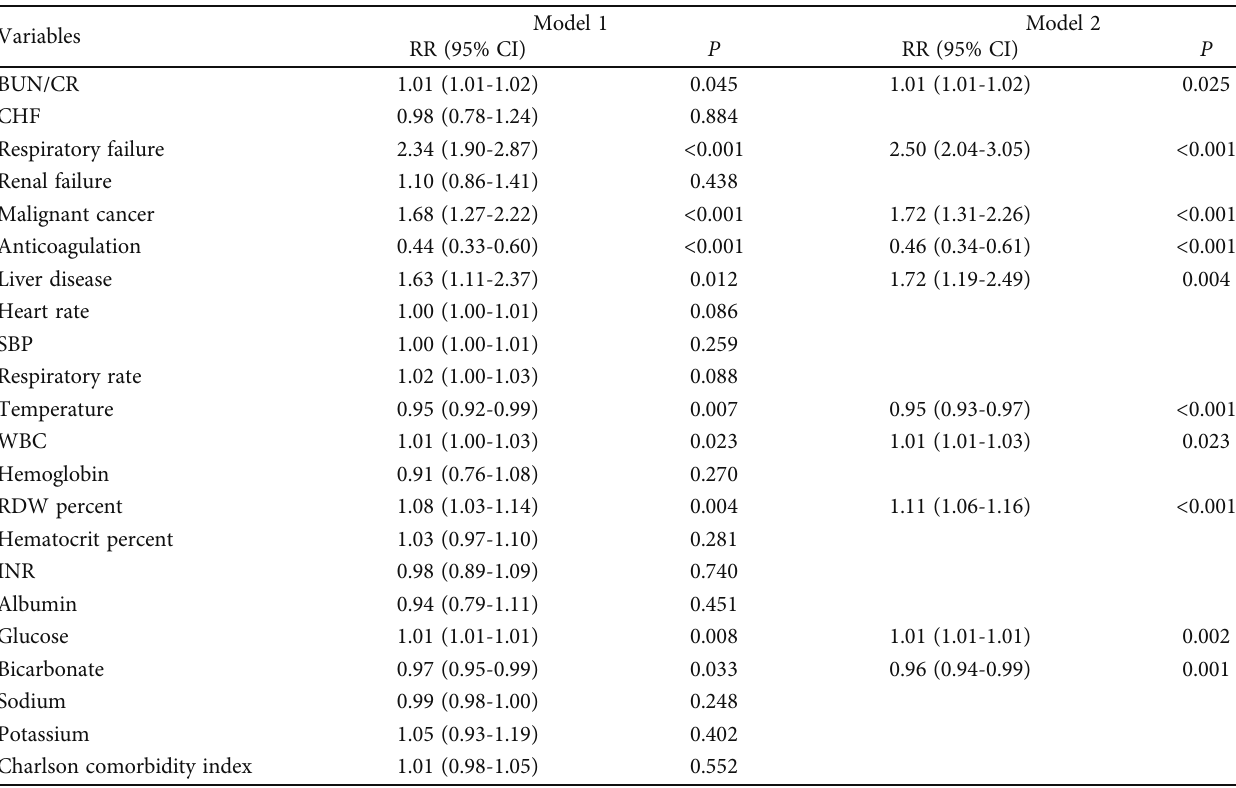
Table 2: The association between BUN/Cr and mortality of participants with cerebral